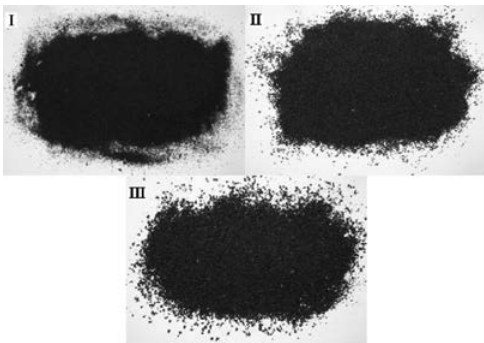
Fig. 1. Scrap-tire particles: crumb rubber I – 0.5–1 mm; crumb